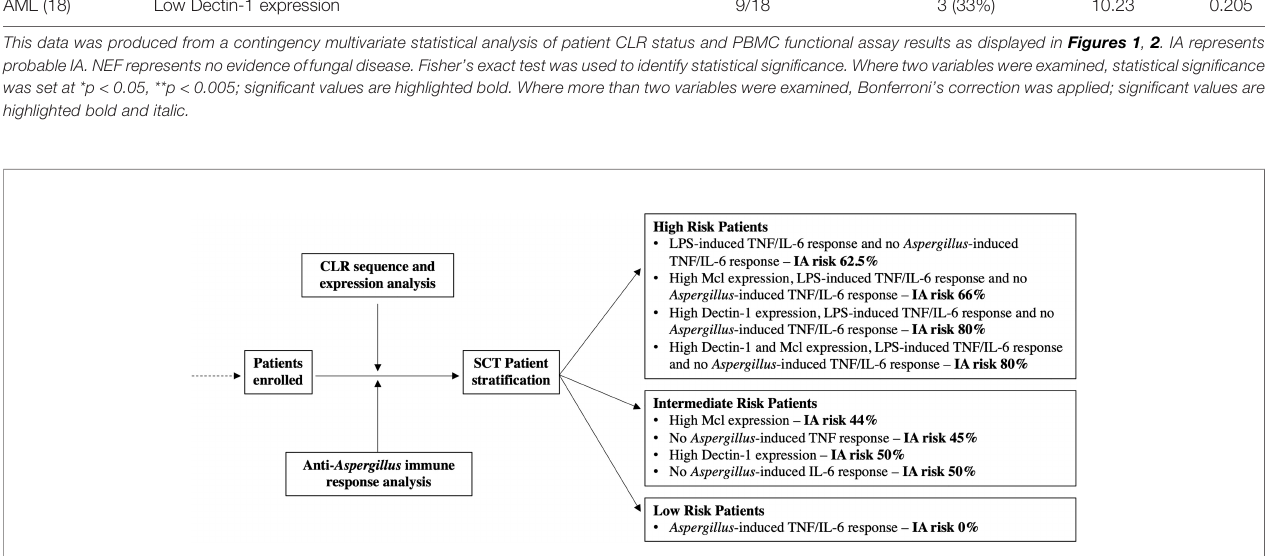
FIGURE 3 | Strati fi cation of SCT patients according to IA susceptibility using risk factors identi fi ed in this study. This schematic fi gure was produced from the results displayed Figures 1 , 2 and Table 4 . The proposed strategy utilises the risk factors and incidence of IA from this study and strati fi es patients into three groups according to IA susceptibility.